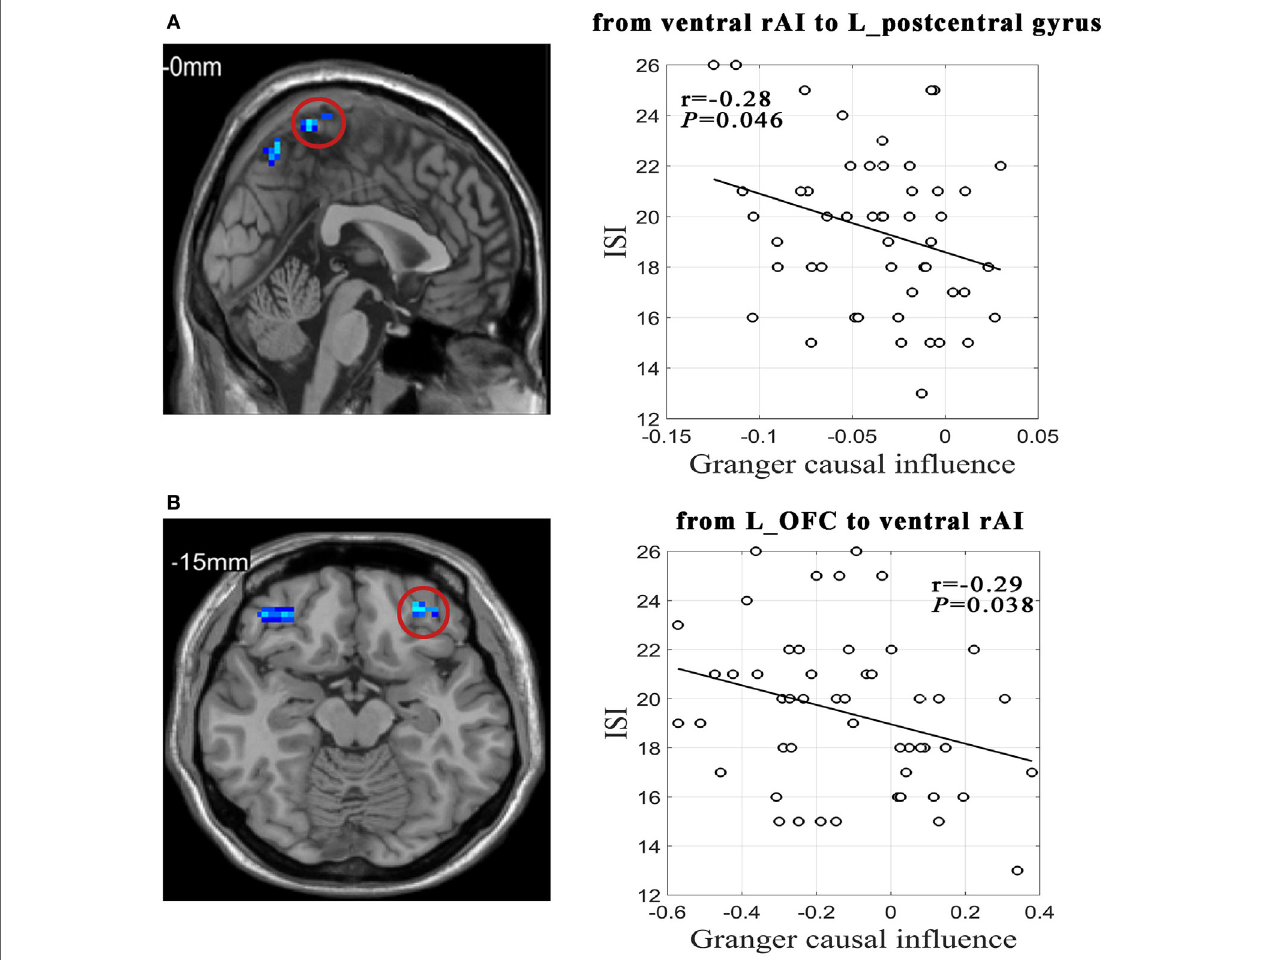
FigUre 2 | Relationships between effective connectivity and sleep and emotion scales in primary insomnia group. (a) Scatter plot shows correlation between effective connectivity value from ventral right anterior insula (rAI) to left postcentral gyrus extending to bilateral precuneus and Insomnia Severity Index (ISI) scores. (b) Scatter plot shows correlation between effective connectivity value from left orbitofrontal cortex (L_OFC) to ventral rAI and ISI.